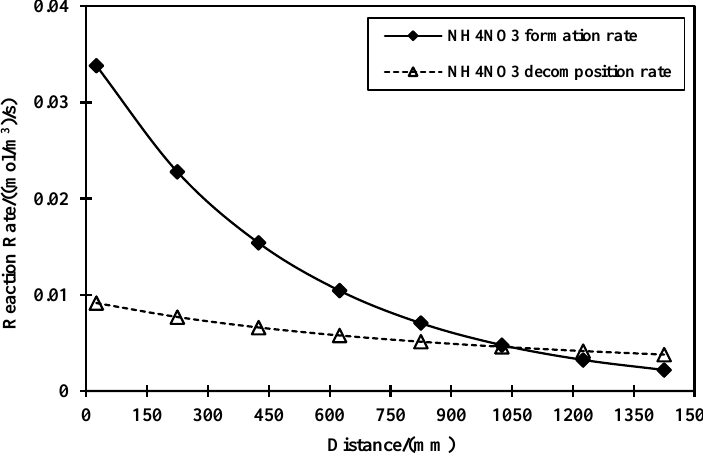
Figure 9. The relationship between the NH 4 NO 3 formation and decomposition reaction rate before the reactor inlet and the distance (T = 150 °C, NO 2 / NOx = 0.25).